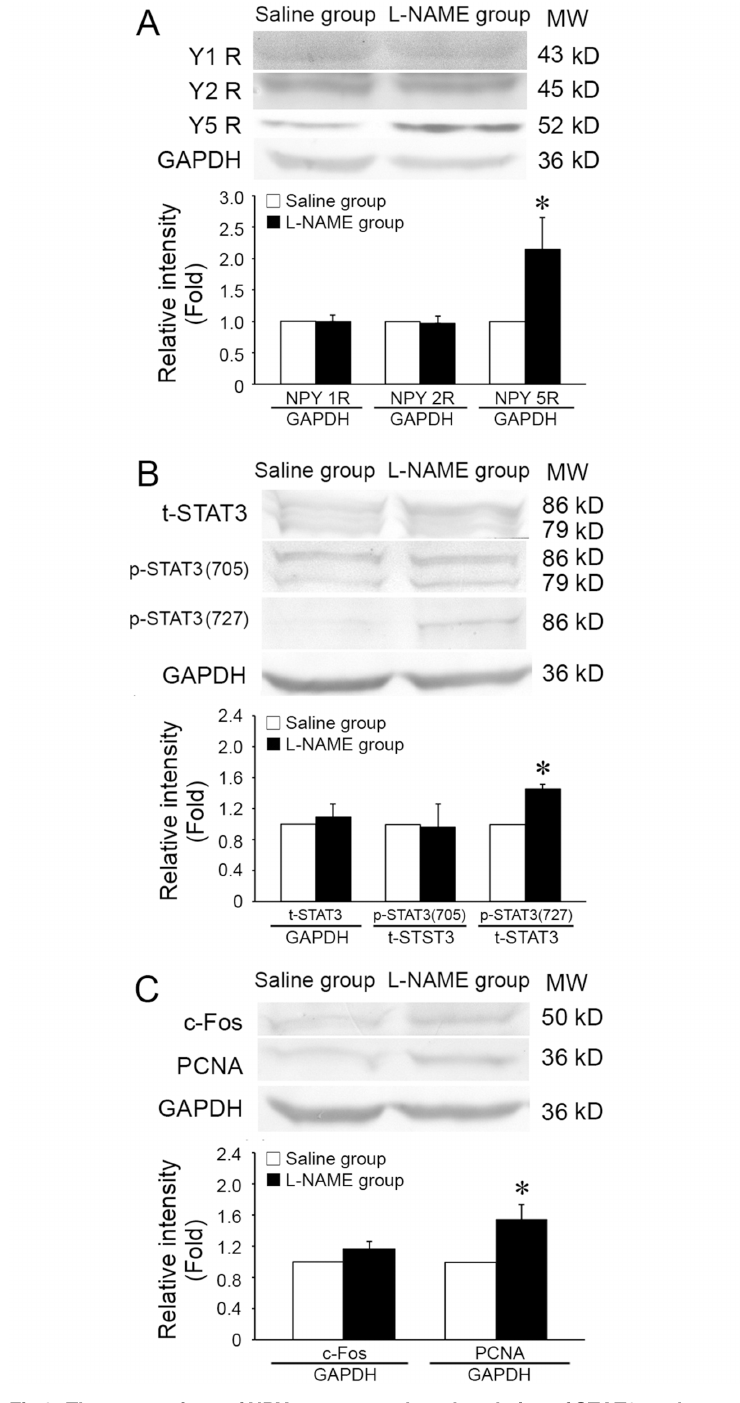
Fig 2. The expressions of NPY receptors, phosphorylation of STAT3, and expressions of c-Fos and PCNA in thoracic aorta of gestational hypertensive rats. (A) The expression of NPY5R was significantly increased, but not NPY1R and NPY2R in L-NAME group compared with that in saline control group (NPY1R and NPY2R, n = 4. NPY5R, n = 3). (B) The phosphorylation of STAT3 at Ser727 residue was significantly increased in L-NAME group, while the expression of total STAT3 and phosphorylation of STAT3 at Tyr705 were not changed (STAT3 at Tyr705, n = 4. total STAT3 and STAT3 at Ser727, n = 3). (C) Compared with saline control group, the expressions of c-Fos and PCNA were increased in L-NAME group (c-Fos, n = 3. PCNA, n = 4). Shown values are the mean ± SD , * P < 0.05 v . s . the saline control.